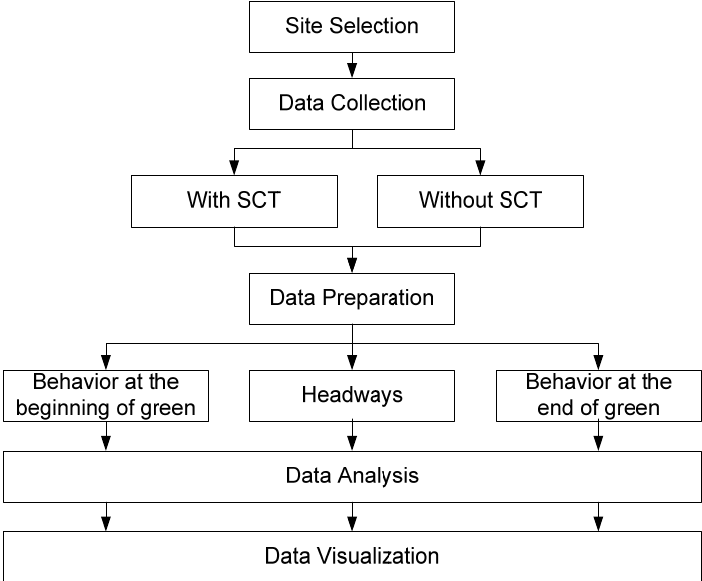
Figure 6. Flowchart of data analysis.